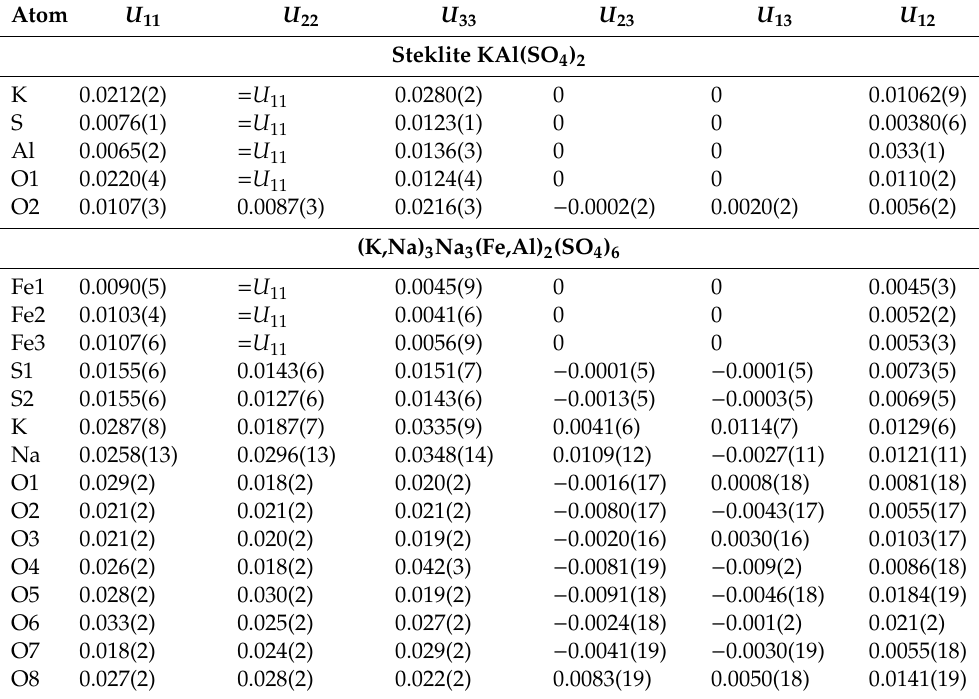
Table 3. Anisotropic displacement parameters of atoms (Å 2 ) for the crystal structures of steklite and (K,Na) 3 Na 3 (Fe,Al) 2 (SO 4 ) 6 .